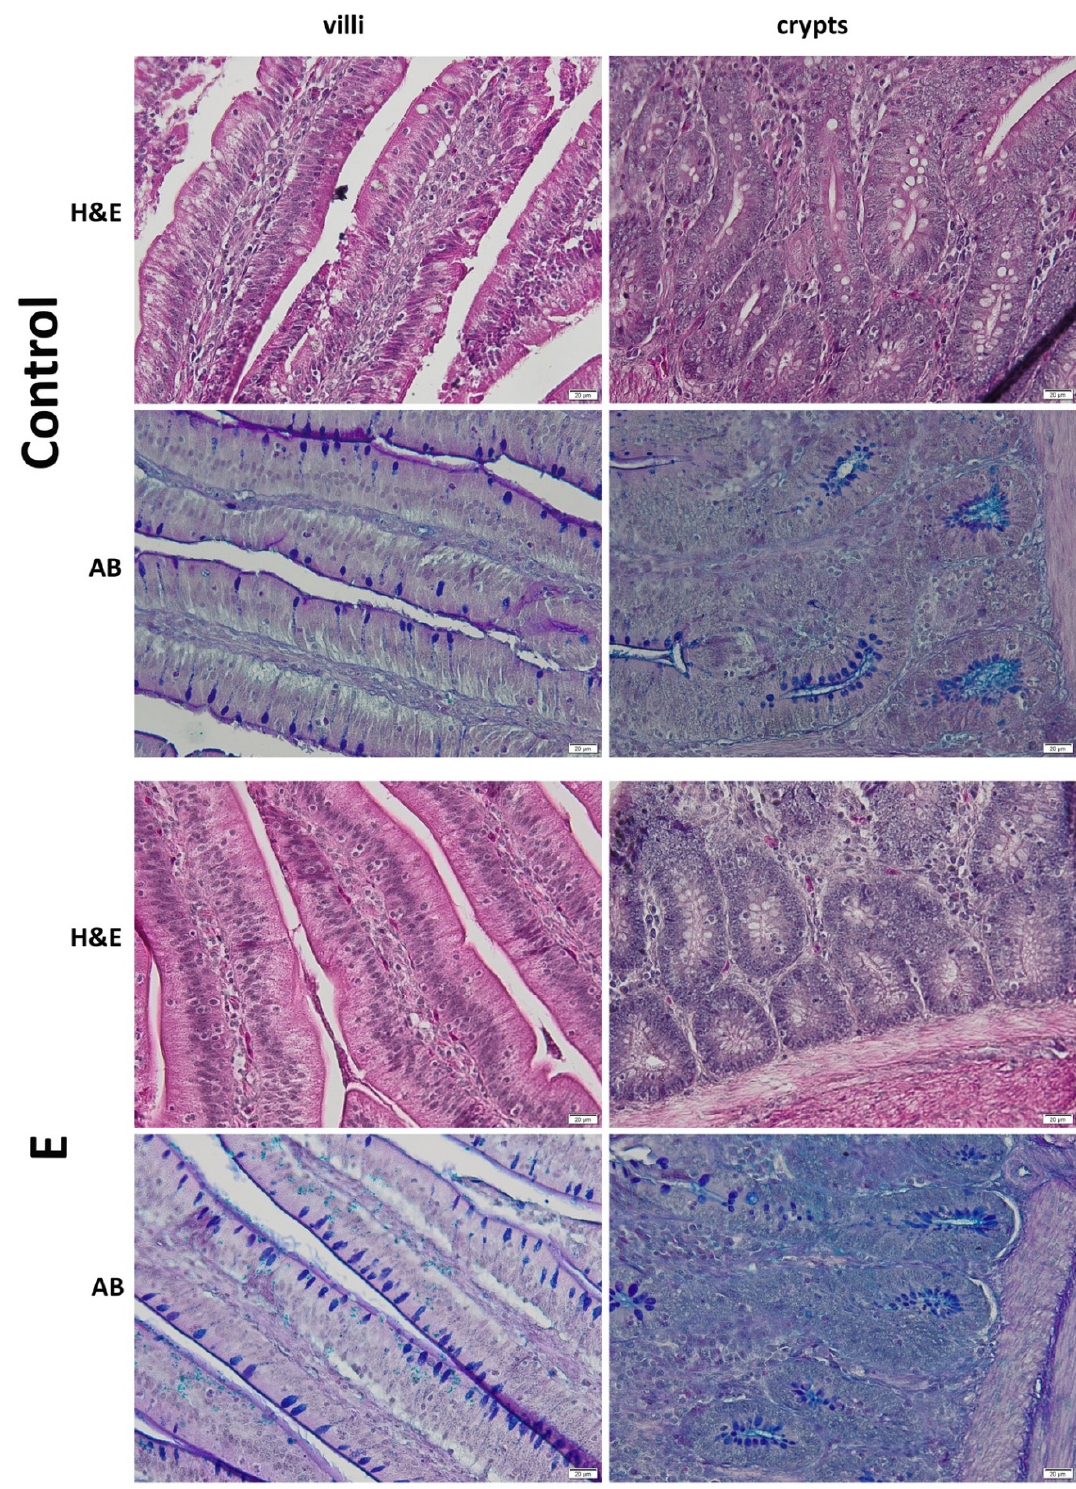
Figure 1. Histological aspects of the duodenal villi and crypts for the control and experimental (E) groups via hematoxylin and eosin (H&E) and Alcian blue (AB) staining. Scale bar = 20 μ m.